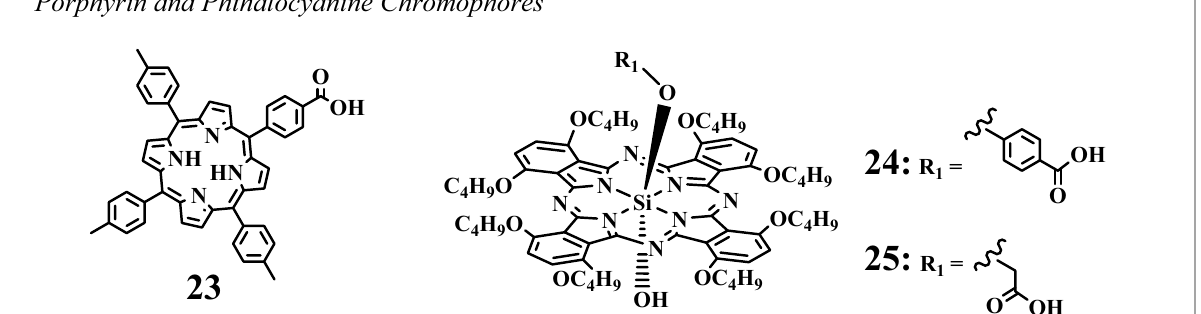
Fig. 5 Structures of metal-free chromophores 11 , [51] 12 , [62] 13 , [62] 14 , [62] 15 , [69] 16 , [69] 17 , [70] 18 , [71] 19 , [72] 20 , [73] 21 , [74] 22 , [75] 23 , [12] 24 , [12] and 25 [12] used in selected DSPEC